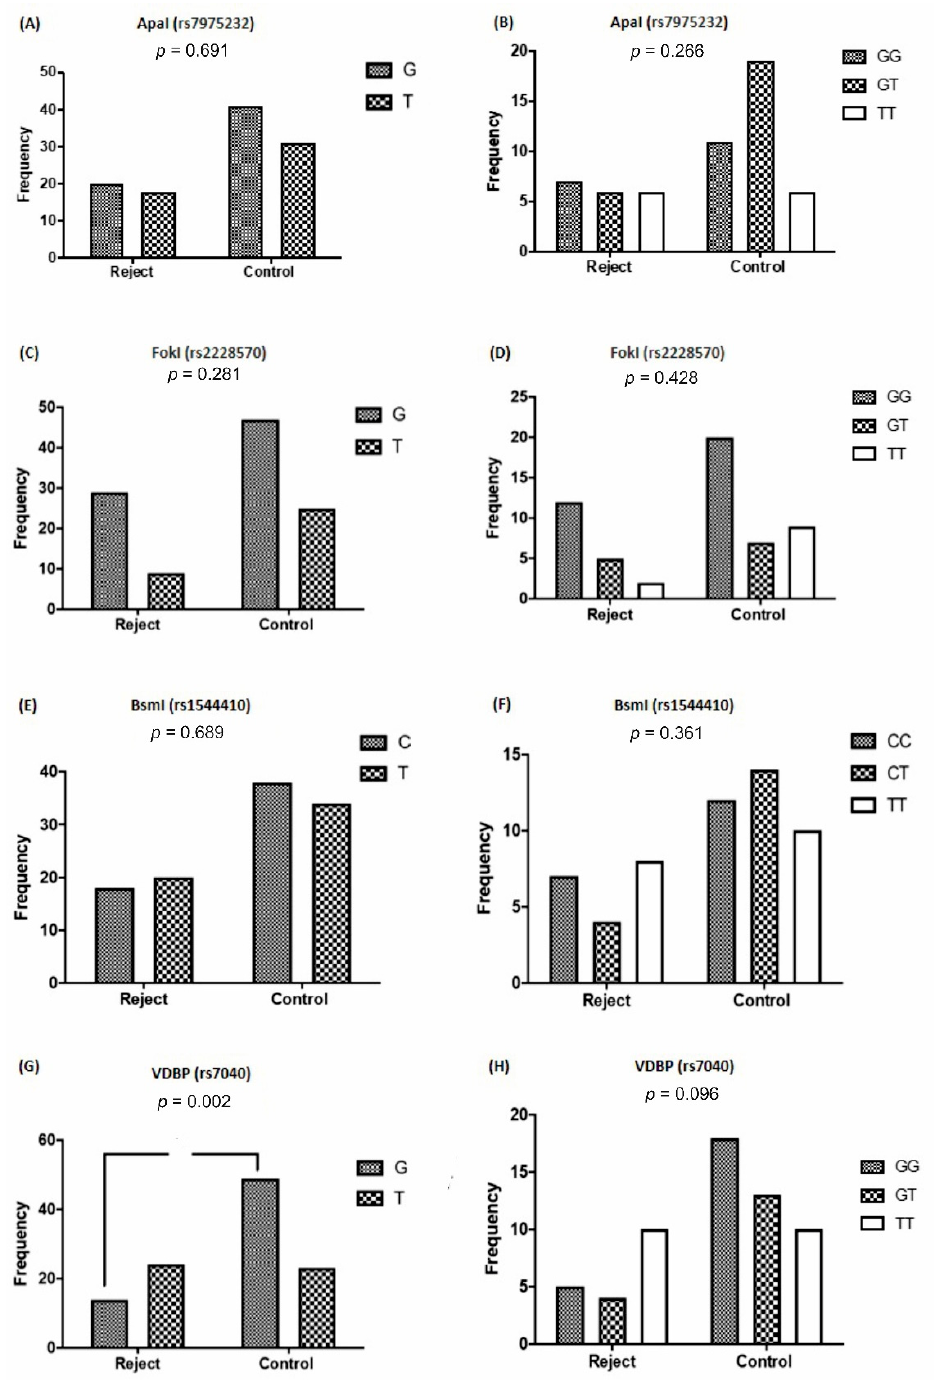
Figure 4. Frequencies of VDR and VDBP polymorphisms in the allograft rejection and healthy groups. ( A , B ) Apa I, ( C , D ) Fok I, (E,F) Bsm I, and ( G , H ) rs7040 polymorphisms. VDR: vitamin D receptor; VDBP: vitamin D-binding protein.